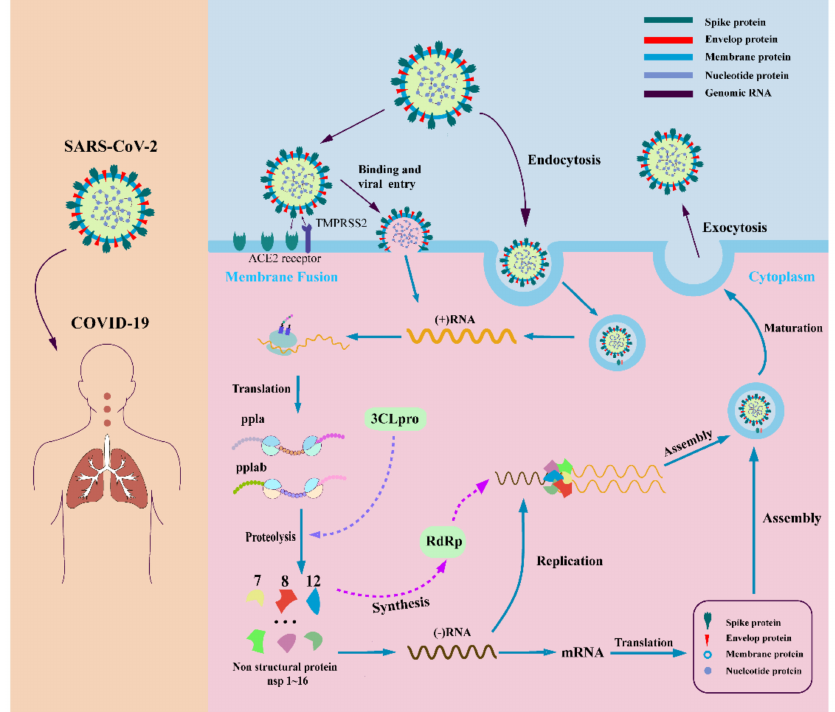
Figure 1. SARS-CoV-2 infection mechanism. SARS-CoV-2 enters the host cell by binding to specific host cell receptors and becoming endocytosed. The materials in the host cell are used to produce materials needed for viral replication and assembly by viral genes. After maturation of the virus, release into the extracellular space occurs.